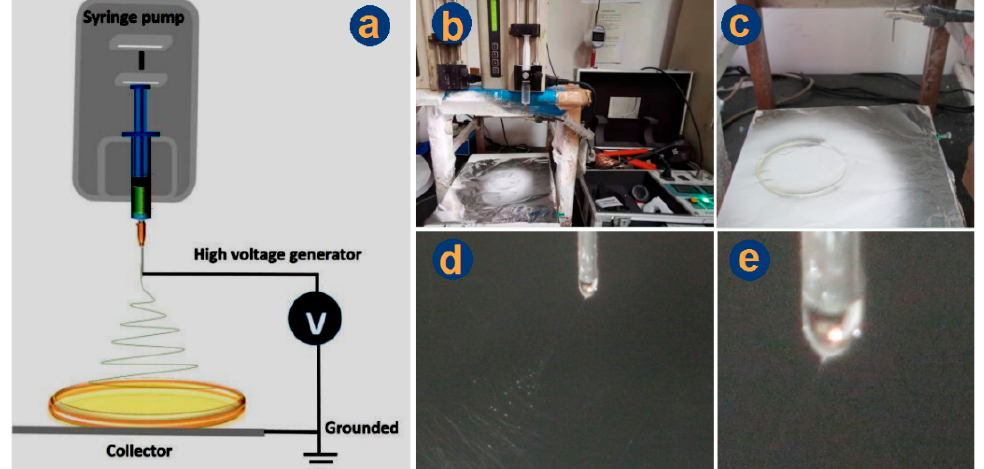
Figure 4. The combination of electrospinning and casting for preparing double-layer hybrid films: ( a ) a diagram showing the combination; ( b ) a digital photo about the whole system; ( c ) the collection of nanofibers by the glass, a Petri dish; ( d ) a typical electrospinning process; ( e ) the Taylor cone.